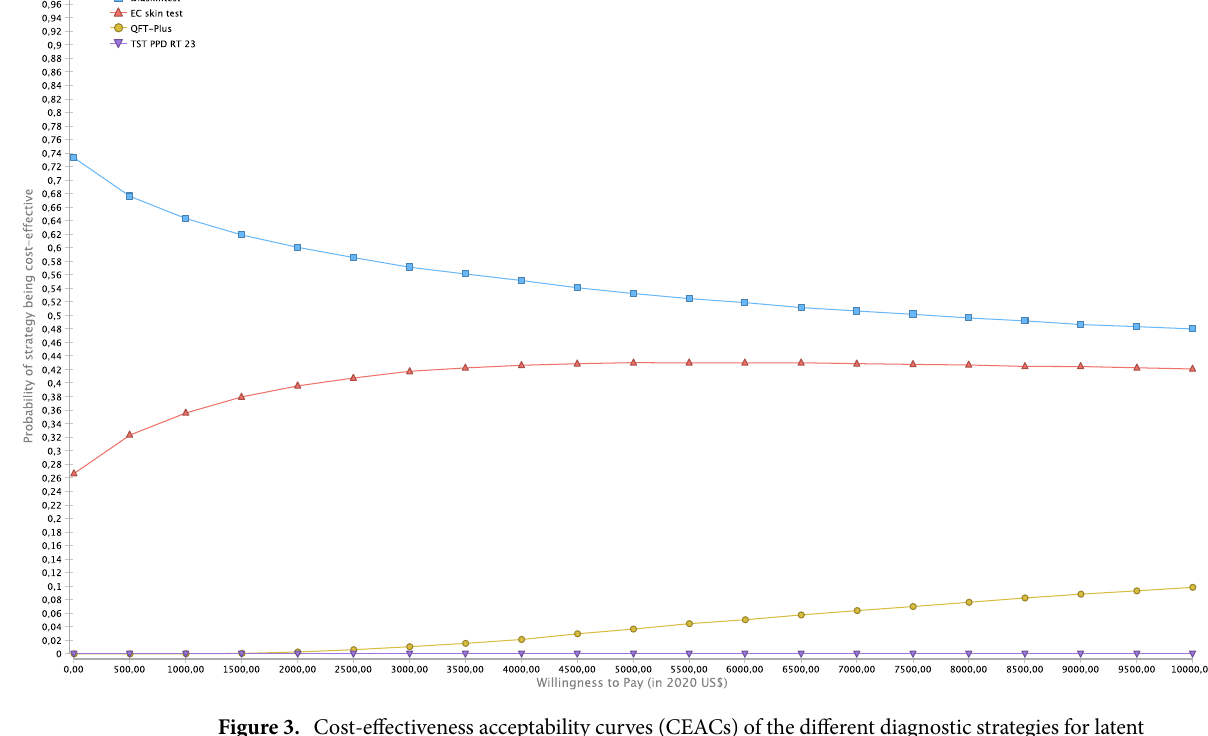
Figure 3. Cost-effectiveness acceptability curves (CEACs) of the different diagnostic strategies for latent tuberculosis infection. Cost effectiveness acceptability curves using the net-monetary benefit approach (10,000 Monte Carlo iterations) represent the probability (y-axis) that each strategy is more cost effective compared at the range of willingness to pay thresholds (US$ per quality-adjusted life-year [QALY]) on the x-axis. The curve is generated by repeating the procedure for various thresholds, with the threshold on x-axis and the probability to be cost effective on y-axis. Acceptability curves are presented here taking into account direct costs only. CEAC